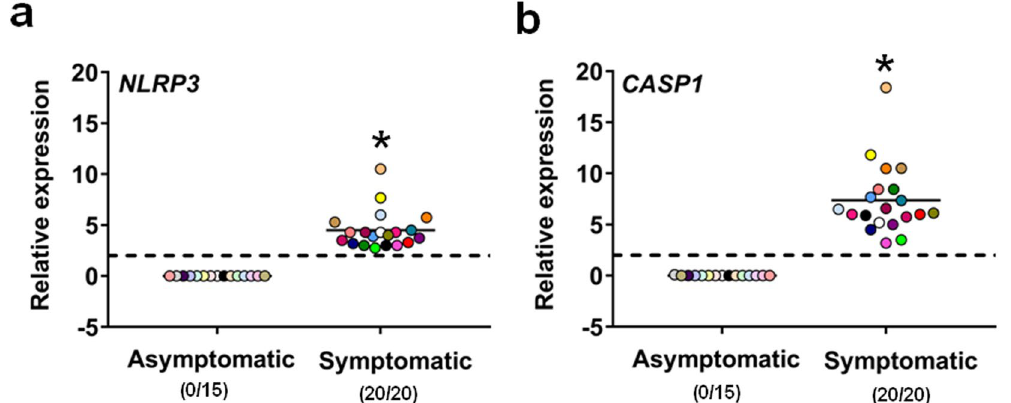
Figure 3. Quantitative analysis of NLRP3 and CASP1 gene expression. Vaginal samples of asymptomatic (n = 15, identified by dots with different colors) and symptomatic (n = 20, identified by dots with different colors) women were centrifuged at 3000 rpm for 10 min, then cellular fractions were lysed and total RNA was extracted and retro-transcribed in cDNA. The expression levels of NLRP3 ( a ) and CASP1 ( b ) genes in asymptomatic and symptomatic women were calculated by comparative Ct method (2 − ∆ Ct formula) after normalization with GADPH gene. The results are from triplicates samples of each subject and the statistical significance was determined with Mann Whitney U test. The dashed line denotes the cutoff at which the overexpression of NLRP3 and CASP1 genes was defined as > 2 times the value of GADPH expression and the number of women expressing genes is indicated in the brackets. * p = 3 × 10 − 10 symptomatic vs asymptomatic women for NLRP3 and CASP1